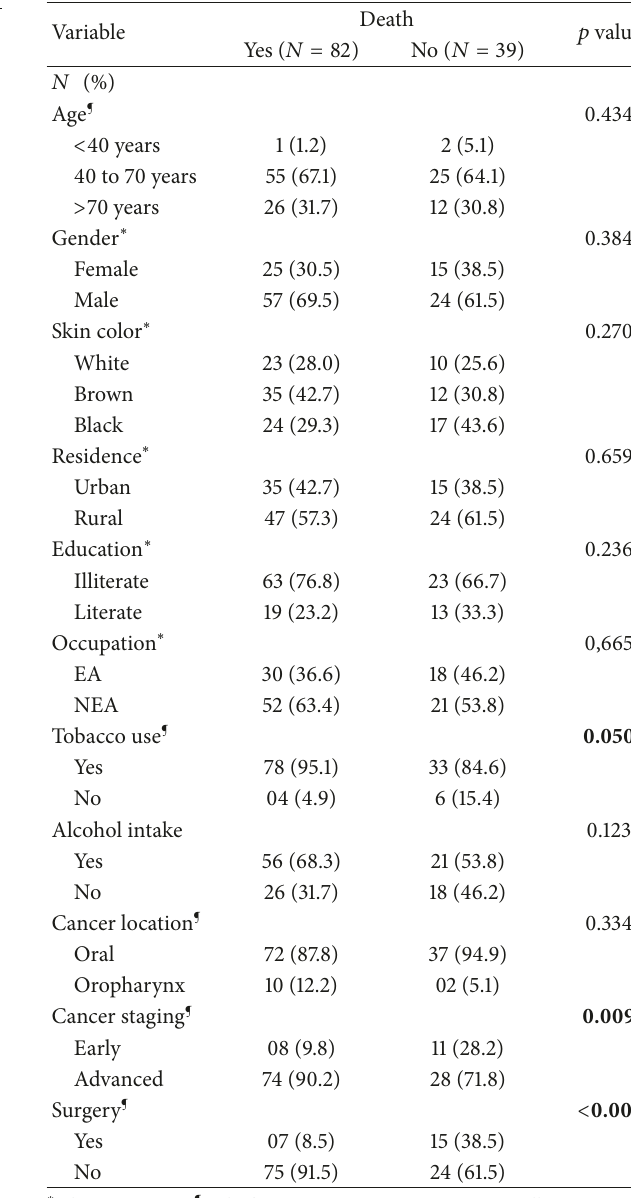
Table 2: Comparison of studied variables between patients with and without death (oral cancer/SCC) after diagnosis of oral and oropharyngeal